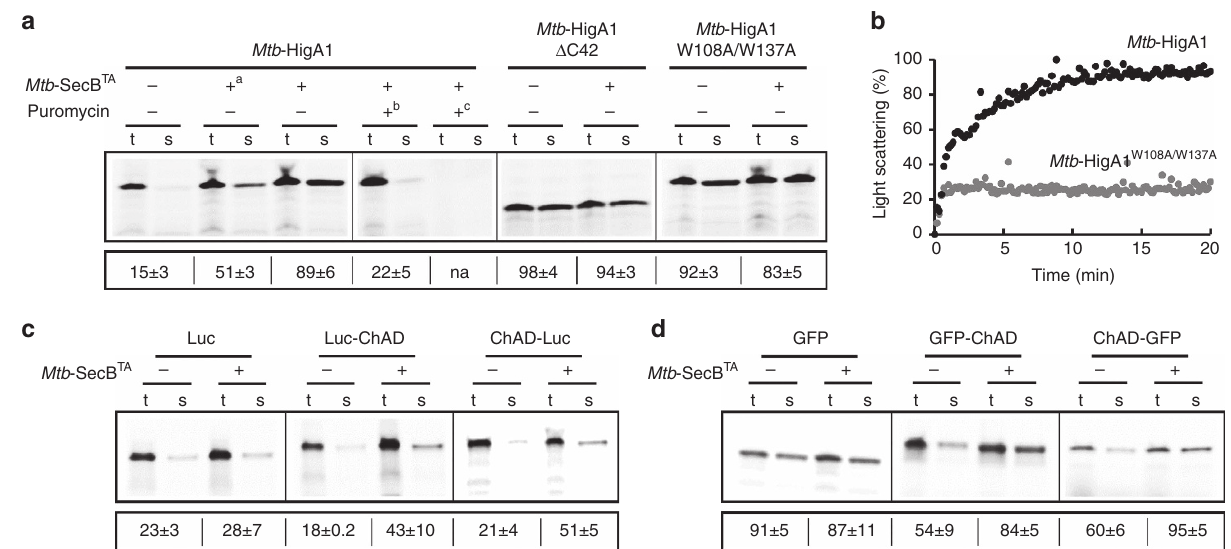
Figure 2 | The chaperone facilitates the folding of Mtb -HigA1 and other unrelated proteins only in the presence of ChAD. ( a ) Folding of newly translated Mtb -HigA1 relies on Mtb -SecB TA when the ChAD extension of Mtb -HigA1 is present. Mtb -HigA1, Mtb -HigA1 D C42 and Mtb -HigA1 W108A/W137A were independently expressed in a cell-free translation system with or without Mtb -SecB TA . Translation products were labelled with [ 35 S]methionine. Mtb -SecB TA concentrations were 8 m M otherwise stated ( þ a indicates 4 m M) and reactions were performed for 1h at 37 (cid:2) C. When indicated, 0.4mM of puromycin was added, either from the start of the translation reaction ( þ c ) or 30min after ( þ b ), to release ribosome-bound nascent chains for 1h, and the chaperone was then added for 1h at 37 (cid:2) C. After translation, the total (t) and soluble (s) fractions were separated on SDS–PAGE and quantified by phosphorimager. The numbers below the electrophoretic pattern represent the mean solubility values (%), calculated by the ratio of the amount of translation products in the soluble (s) and total (t) fractions obtained from three different translation experiments. The s.d. is indicated. ( b ) In vitro aggregation kinetics of urea-denatured Mtb -HigA1 and Mtb -HigA1 W108A/W137A (4 m M) followed at 25 (cid:2) C by monitoring light scattering at 355nm. ( c ) Effect of Mtb -SecB TA on the solubility of nascent luciferase (Luc) and chimeric luciferase containing C-terminal ChAD (Luc-ChAD) or N-terminal ChAD-luciferase (ChAD-Luc) and ( d ) on the solubility of nascent GFP and chimeric GFP-C-terminal ChAD (GFP-ChAD) and N-terminal ChAD-GFP (ChAD-GFP), as performed in a , with or without Mtb -SecB TA (8 m M). Full phosphorimager images for a , c and d are shown in Supplementary Fig.